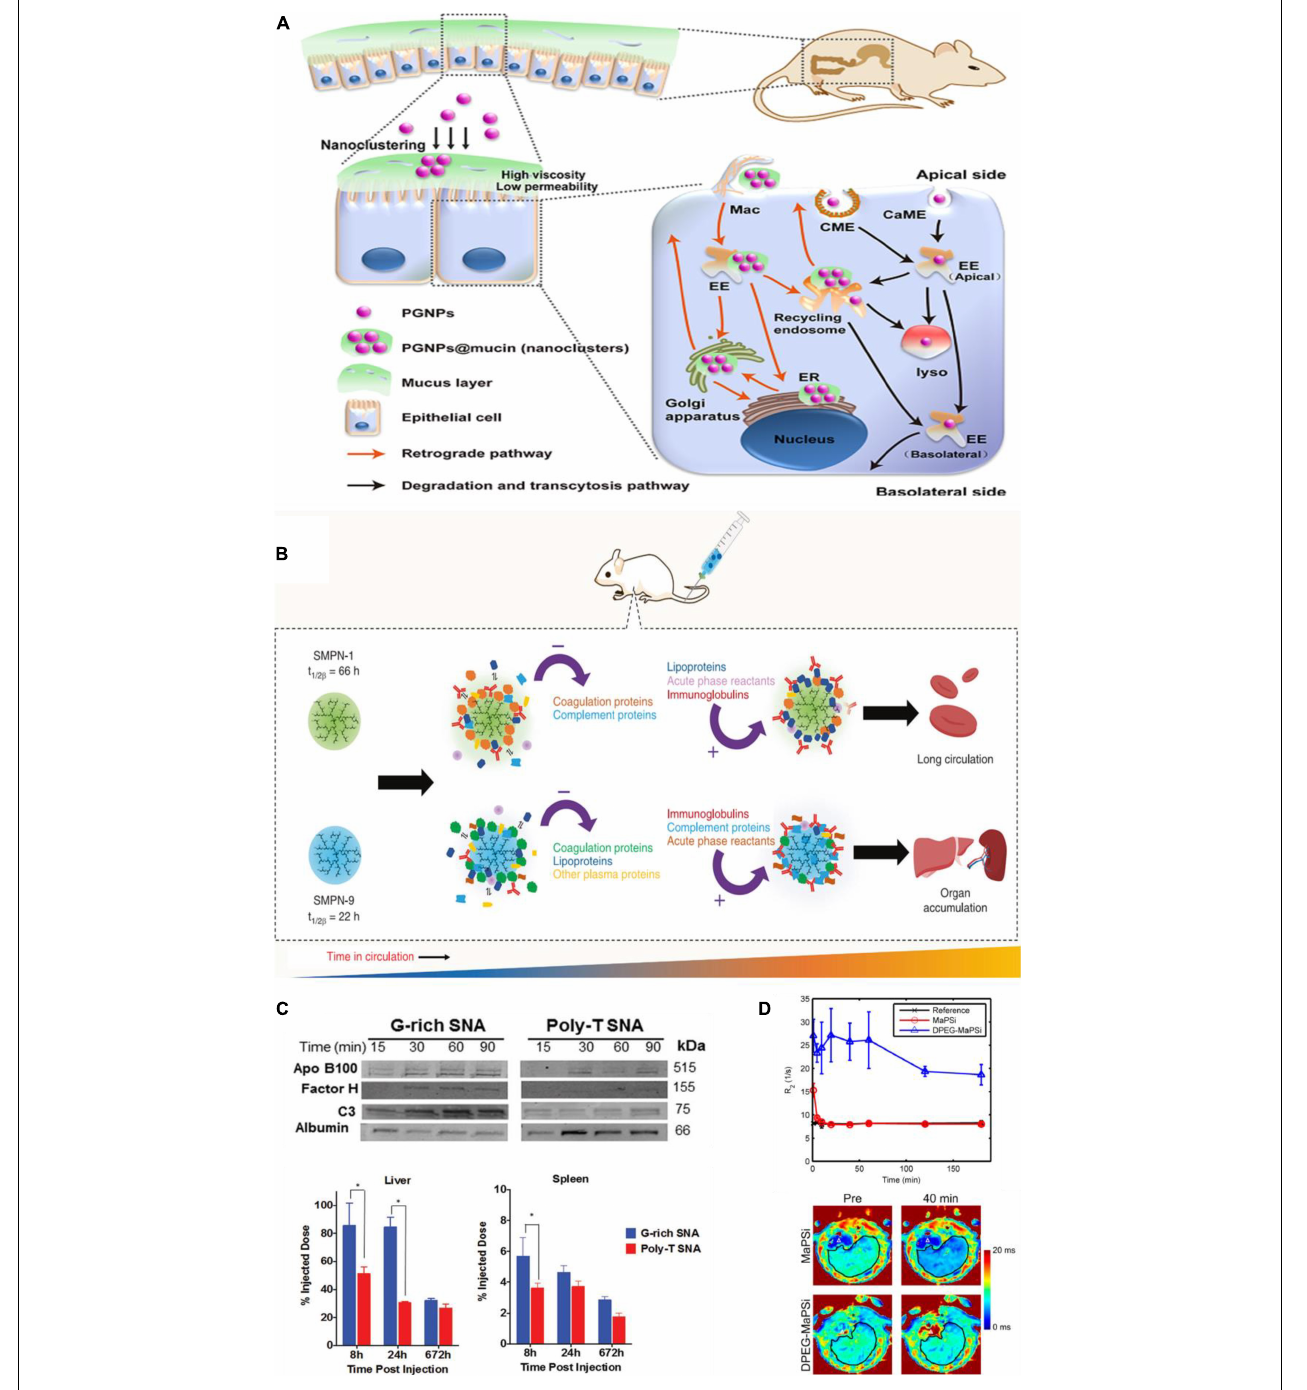
FIGURE 1 | Protein corona impacts in vivo biobehaviors of ENPs. (A) Schematic diagram of intestinal mucus altering the endocytosis and transcytosis characteristics of PGNPs. Adapted with permission from Yang et al. (2018). (B) PC affects circulation time. Coagulation and complement proteins that were adsorbed initially on the surface of SMPN-1 were released during the circulation and accumulation of lipoproteins and acute phase reactants happened over 48 h on the surface. In contrast, short-circulating SMPN-9 had high abundance of complement proteins and acute phase reactants at 48 h. Adapted with permission from Abbina et al. (2020). (C) PC influenced the biodistribution of G-rich and poly-T SNAs. Compared to poly-T SNAs, G-rich SNAs adsorbed more amounts of apolipoprotein B100, complement factor H, and complement C3, and less human serum albumin, which induced more accumulation in liver and spleen. * p < 0.05. Adapted with permission from Chinen et al. (2017). (D) The major part of MaPSi was cleared fast from liver just a few minutes after injection, whereas DPEG-MaPSi decreased the removal rate and prevented the fast decline of theT 2 * relaxation rates. Adapted with permission from Nissinen et al. (2016).